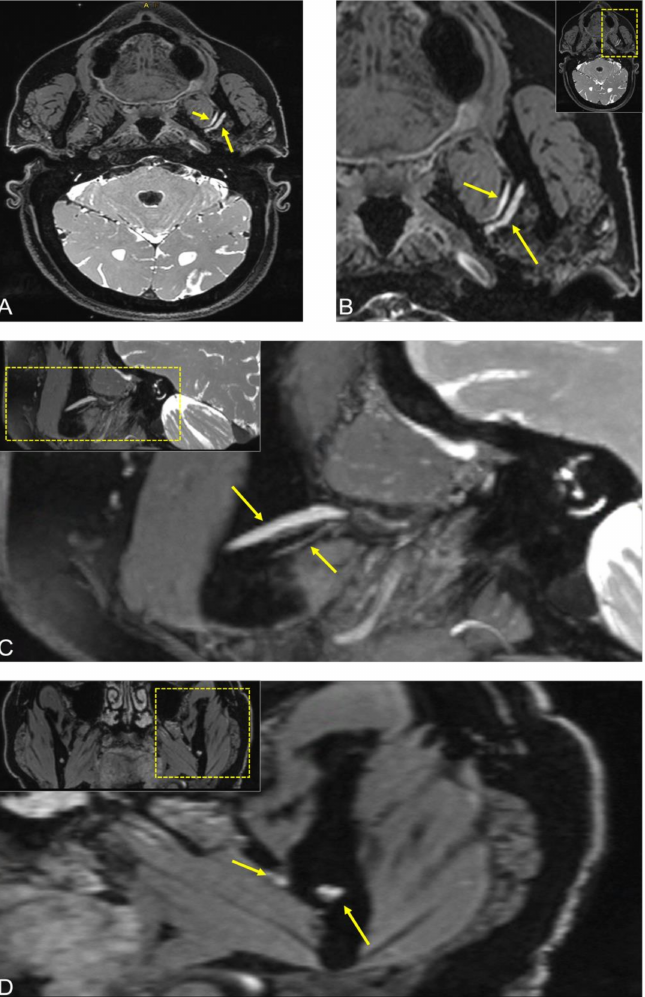
Figure 1. 3D Double-Echo Steady State (DESS) MRI of a patient complaining of constant numbness in the left cheek, chin, and mandible, partly with radiation to the ear and temporal area. The DESS protocol showed osseous signal alteration on the left mandible in the third quadrant in the molar region. ( A , B ) Axial, ( C ) sagittal, and ( D ) coronal side-by-side comparison of the image reconstructions showed hyperintense signal alterations of the mandibular nerve from the oval foramen through its branches in the inferior alveolar nerve and lingual nerve to the region of the third molar. In all images, the short arrow shows signal hyperintensities of the lingual nerve at the anatomic point where it begins to pass from lateral to medial, and the longer arrow represents the inferior alveolar nerve before it enters into the mandibular foramen. For orientation, the dotted rectangles in the corner show the enlarged